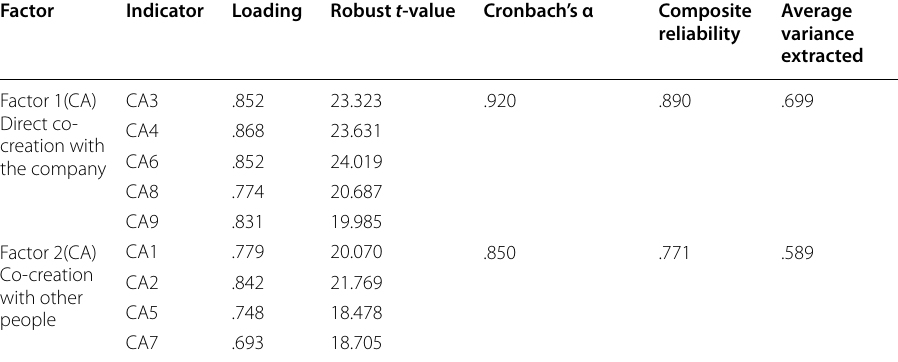
Table 7 Discriminant validity of the theoretical construct measures: co‑creation activities (CA) F1(CA) F2(CA) The diagonal represents the AVE; above the diagonal, the 95% confidence interval for the estimated factor correlations is provided; below the diagonal, the shared variance (squared correlations) is represented